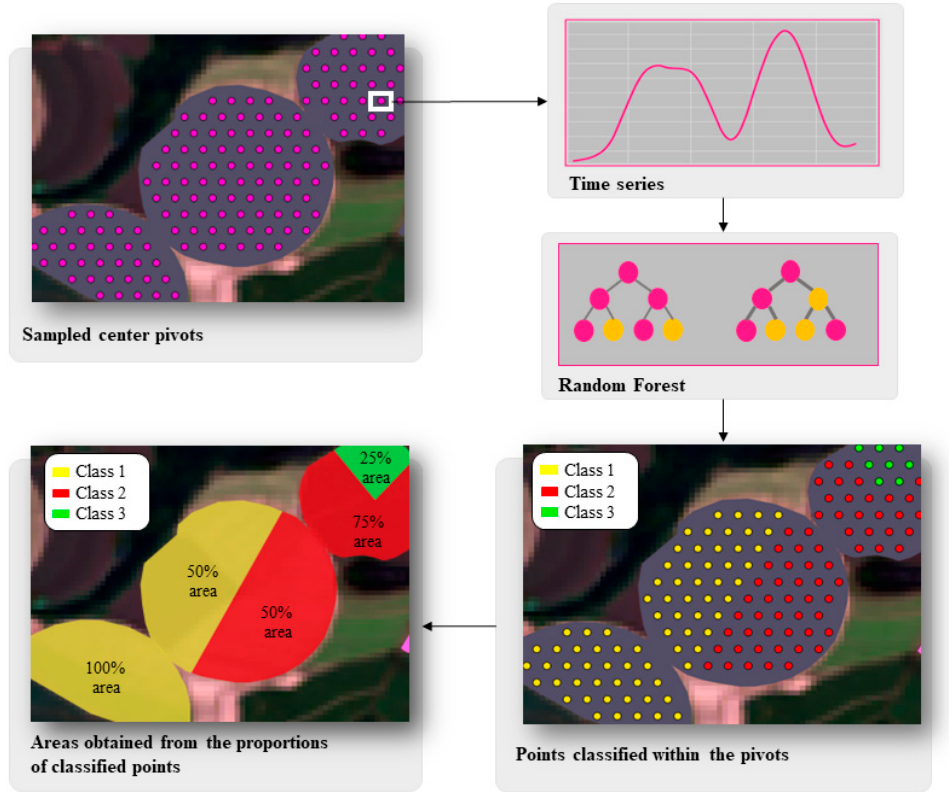
Figure 4. Flowchart of agricultural mapping in each center pivot.